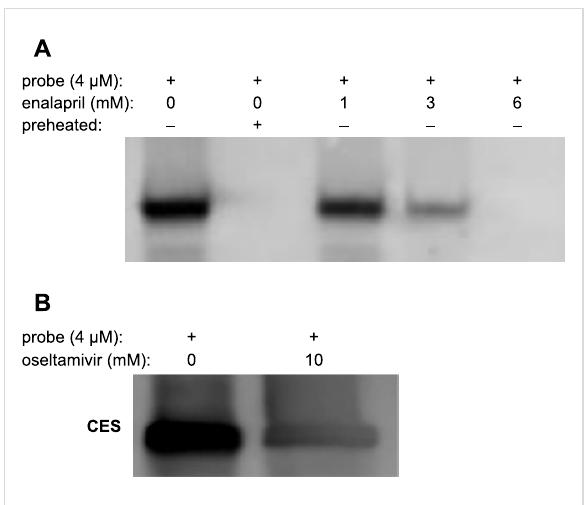
Figure 4: Competition assay between FP–PEG–biotin and enzyme hydrolysis reactions. (A) Enalapril at the indicated concentration was incubated in pCES (100 ng/mL) for 15 min, followed by the addition of FP probe 1 and further incubation for 15 min. Reactions were termi- nated by the addition of 5× SDS-PAGE loading buffer and then heated at 85 °C for 5 min. Samples were separated by SDS-PAGE and blotted by streptavidin. (B) Enzyme samples with oseltamivir were treated in the same way as